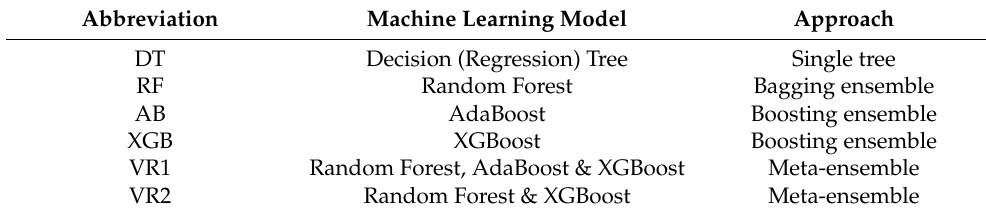
Table 3. Overview of developed VTEC machine learning